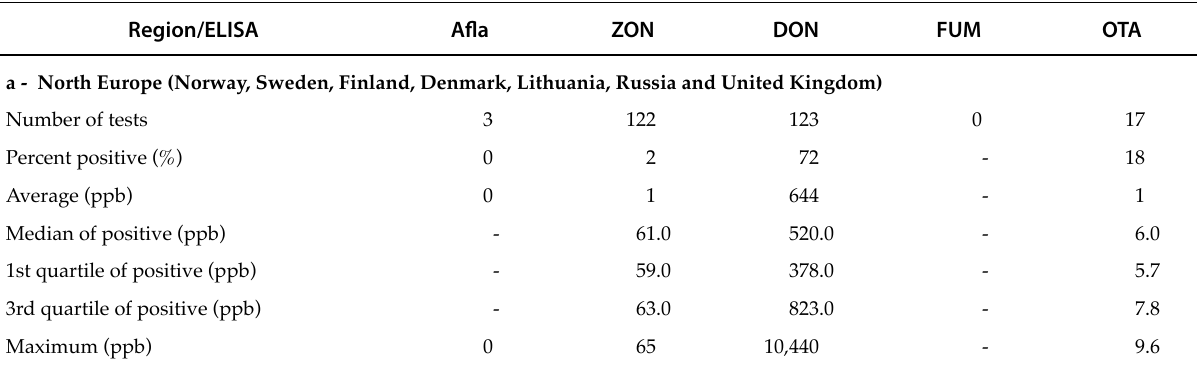
Table 6. Survey results by geographic region (Europe and Middle East regions), determined by ELISA and by HPLC. Region/ELISA Afla ZON DON FUM